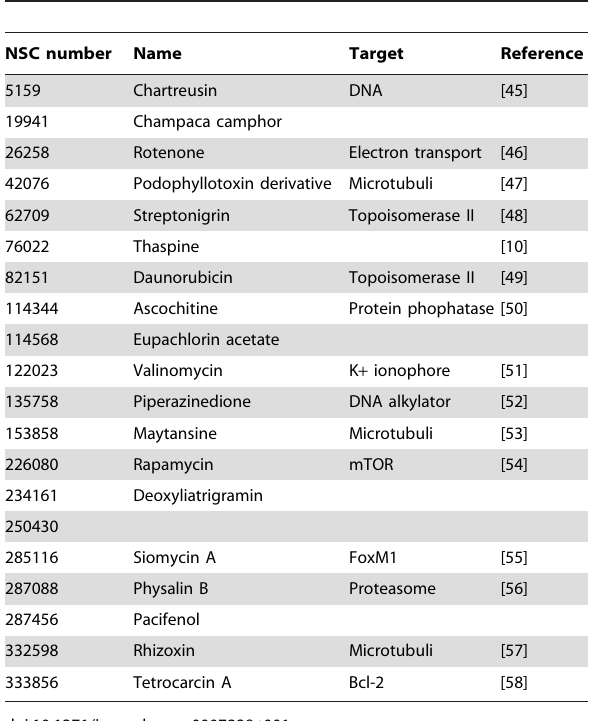
Table 1. Compounds in the NCI Natural Product Set that induce caspase cleavage of CK18 in HCT116